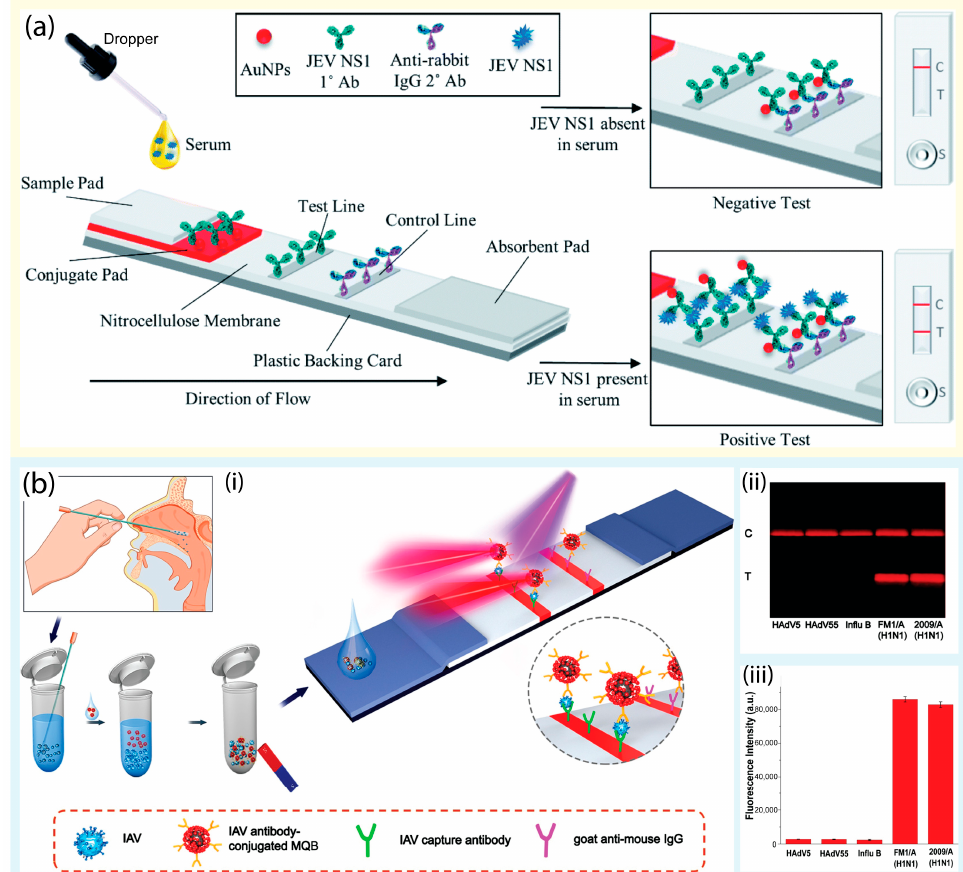
Figure 1. ( a ) Schematic representation of the colorimetric sandwich-based LFA for rapid detection of the Japanese Encephalitis virus using gold nanoparticles. Reprinted with permission from [25]. Copyright (2022) RSC publications. ( b ) Schematic representation of the MQBs-based fluorescent LFA for rapid and enrichment and ultrasensitive detection of influenza A virus in a human specimen. (i) Schematic diagram of influenza A virus detection using MQBs-based LFA. (ii) Images and (iii) corresponding fluorescence intensities of the LFA for H1N1 virions and is insensitive to other respiratory viruses. Reprinted with permission from [27]. Copyright (2020) Elsevier.